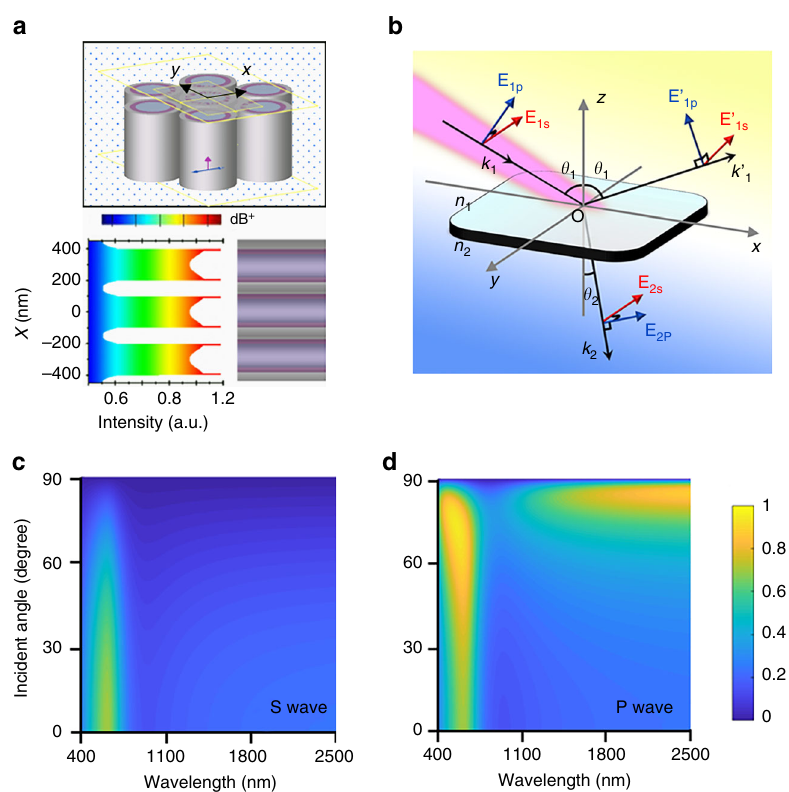
Fig. 4 Simulation of micro grid mode resonance enhanced absorption based polarization optics. a Schematic diagram of the model system: the hexagonal nanotube arrays with deposited hm-C(CN) 3 (top) and Cross-section (bottom) of the simulated electric fi eld distribution of MG@hm-C(CN) 3 . b Ep and Es for the two mutually perpendicular components of Electric vector. Absorption zones of c S-wave and d P wave versus wavelength and incident